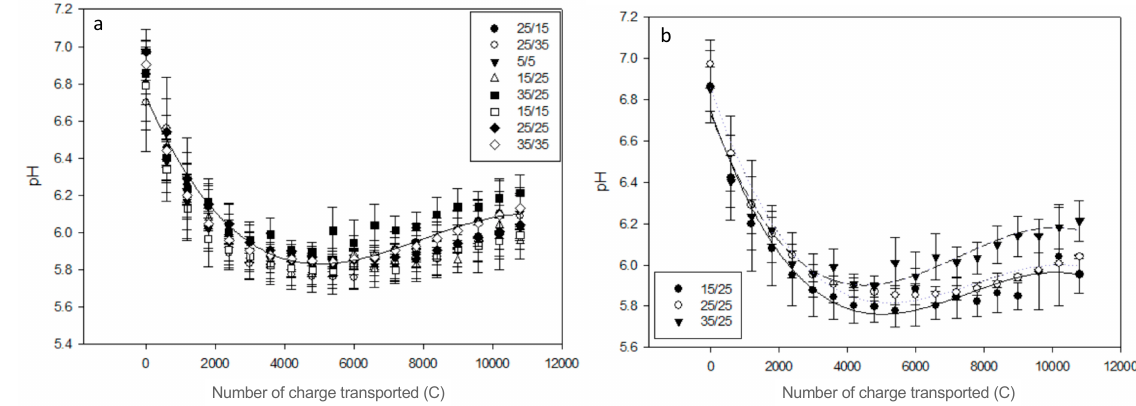
Figure 5. Concentrate solution pH evolution in ( a ) the OAComp for the eight PEF conditions tested and ( b ) for the three conditions representing the effect of pulsation time effect during PEF-ED treatment: 15 s/25 s, 25 s/25 s, and 35 s/25 s.